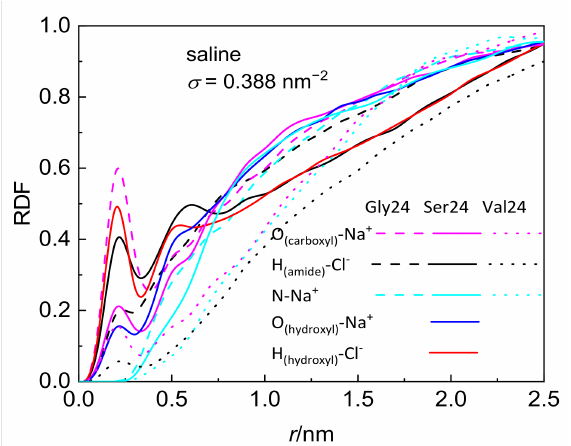
Figure 3. Radial distribution function of pairs comprising selected peptide atoms and sodium cations or chloride anions in systems composed of the peptides interacting with CNT grafted with the PEO chains at σ = 0.388 nm − 2 .